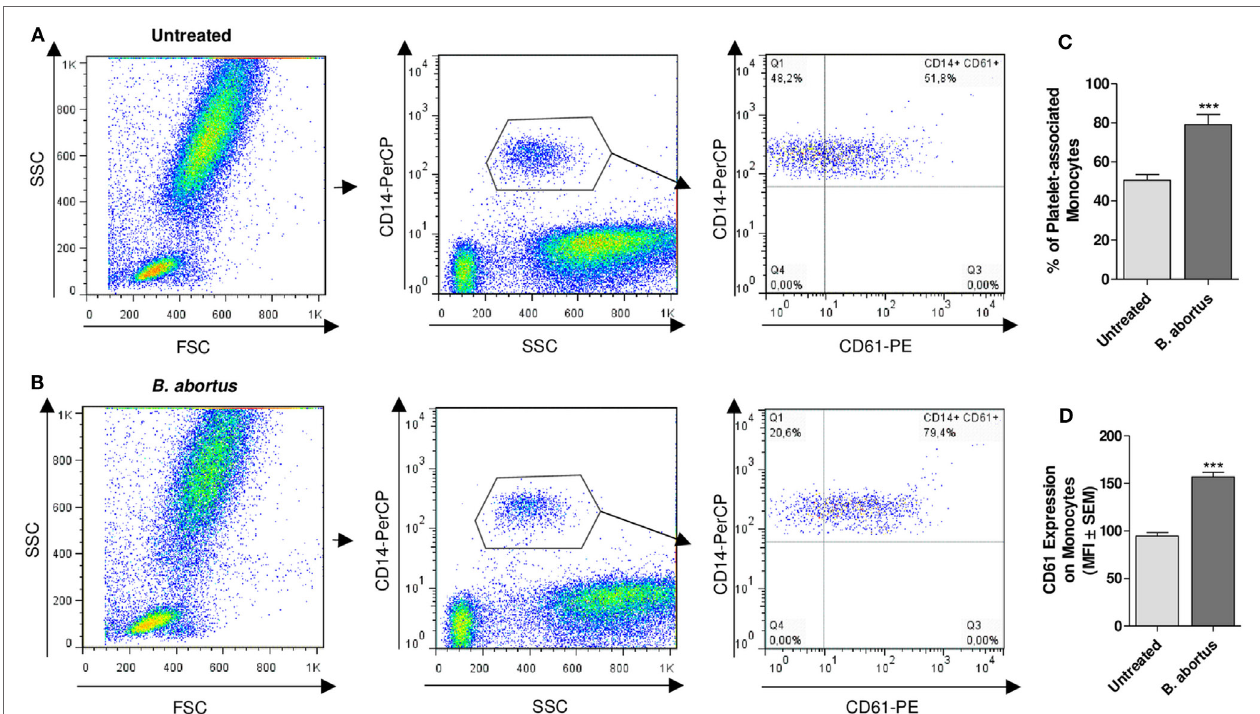
FigUre 4 | Brucella abortus infection promotes platelet–monocyte complexes formation in whole blood. Flow cytometry analysis of whole blood untreated (a) or treated with B. abortus (B) for 30 min. Monocyte population was stained with a PerCP-labeled anti-CD14 Ab and platelet population was stained with a PE-labeled anti-CD61 Ab. Cells were plotted on a CD14 vs. SSC dot plot. Then, the CD14 + cells were plotted on a CD14 vs. CD61 dot plot. Finally, the presence of platelet–monocyte complexes (CD14 + CD61 + ) was determined. (c) Quantification of platelet–monocyte complexes within the CD14 + gate. Data are expressed as the percentage of monocytes associated with platelets (CD14 + CD61 + cells) ± SEM of three independent experiments. (D) CD61 expression in platelet-bearing monocytes (CD14 + CD61 + ). Bars represent the arithmetic means ± SEM of three experiments. MFI, mean fluorescence intensity. THP-1:PTL: Ba 1:100:100. *** P < 0.001 vs.